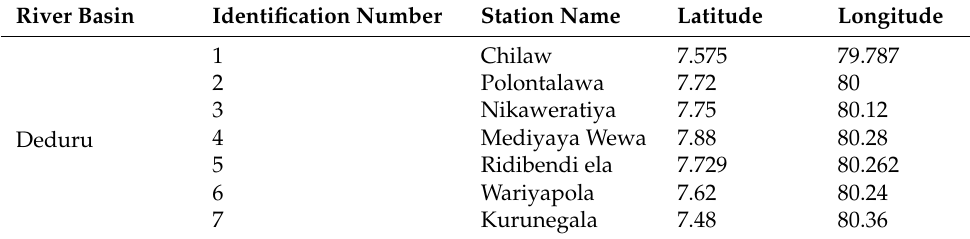
Table 1. Rain gauge